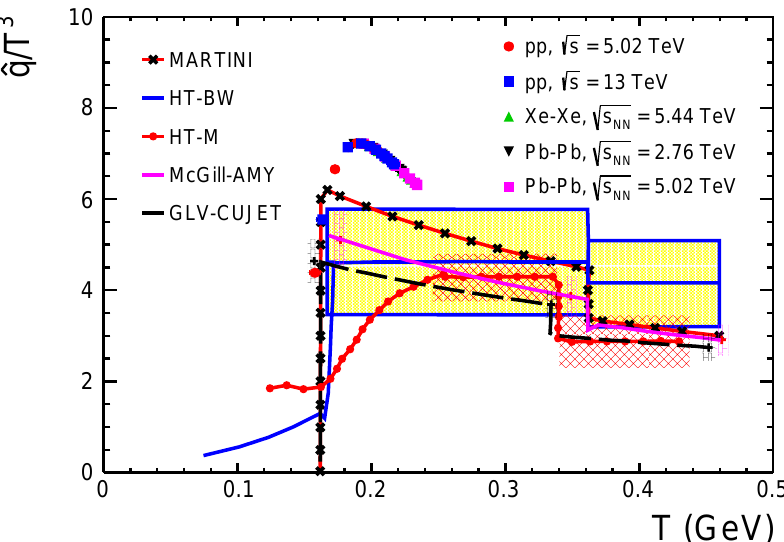
Figure 7. Scaled jet quenching parameter, ˆ q / T 3 , as a function of initial temperature for pp collisions √ √ √ s = 5.02 and 13 TeV, Xe-Xe collisions at s NN = 5.44 TeV and Pb-Pb collisions at s NN = 2.76 and at 5.02 TeV. The yellow band shows the estimated uncertainties under the high-twist high-twist Berkeley– Wuhan (HT-BW) model, whereas the red shaded region shows the corresponding uncertainty in the high-twist Majumder (HT-M) model. See text for